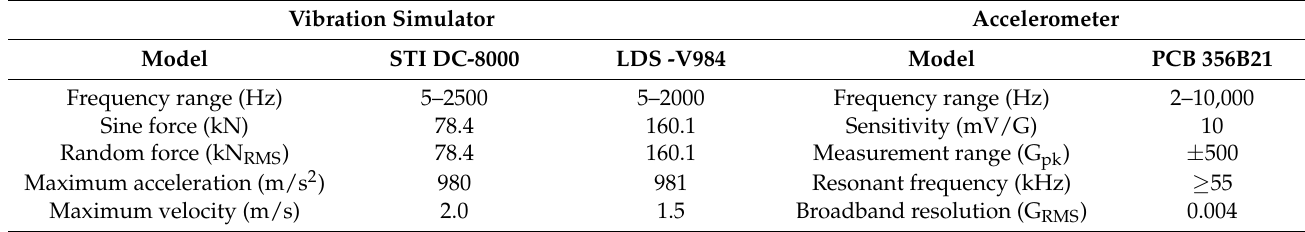
Table 7. Vibration simulator and accelerometer